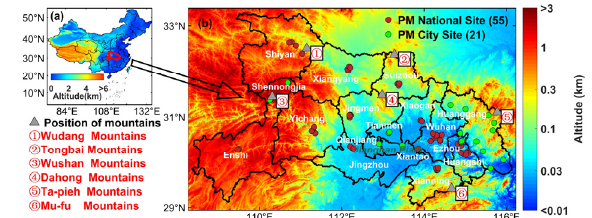
Figure 1. (a) Location of Hubei in China; (b) distribution of PM monitoring sites. The red circles denote national observation sites, while the green ones denote provincial observation sites. The mountains are marked by gray triangles.